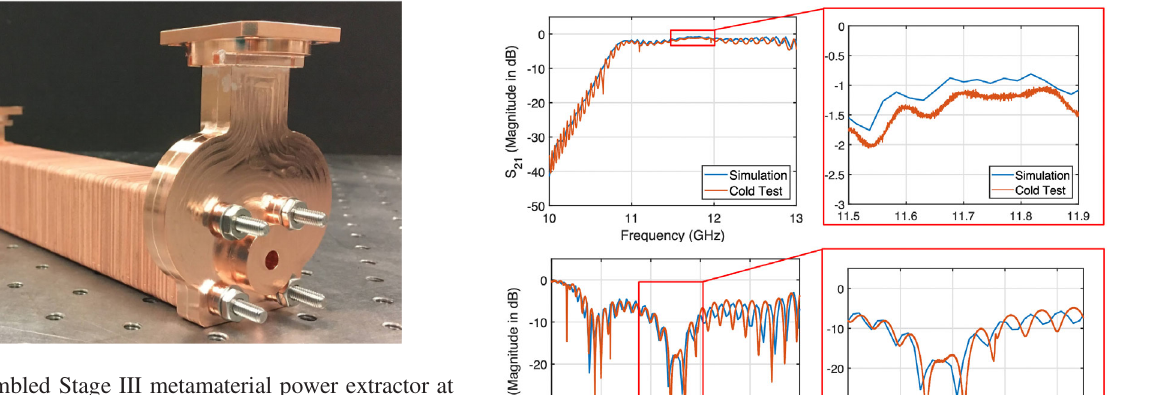
FIG. 10. Assembled Stage III metamaterial power extractor at MIT prior to initial cold tests.